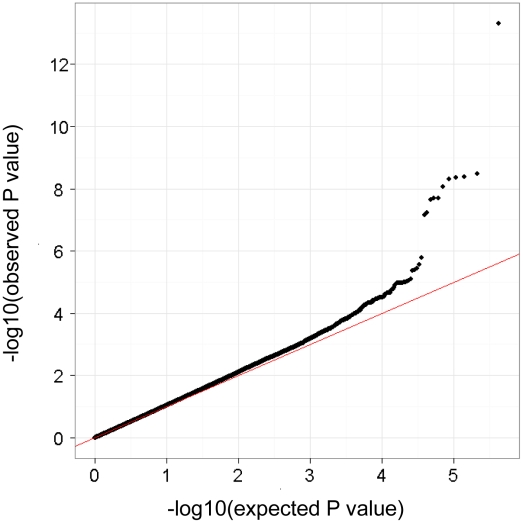
Quantile–quantile (Q–Q) plot of GWAS for pediatric asthma.The results of the Cochrane–Armitage trend P are plotted as dots and the line y = x is in red. The horizontal and vertical lines represent expected P values under null distribution and observed P values, respectively.